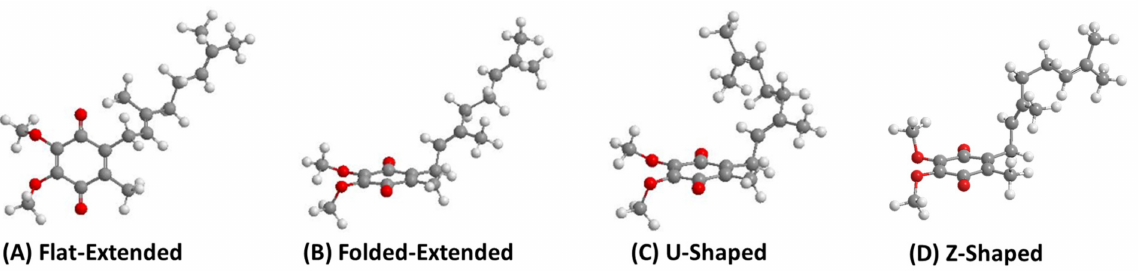
Figure 7. Four different possible conformations, using UQ-2 as an example, describing the relationship between the headgroup and the end of sidechain observed in computational studies. ( A ) Flat- extended conformation, ( B ) Folded-Extended, ( C ) U-Shaped. These images were reported in our recent paper regarding the conformations of UQ-2 [41] and licensed under CC BY 4.0. Here we also include an additional conformation ( D ) Z-shaped, generated using calculations in